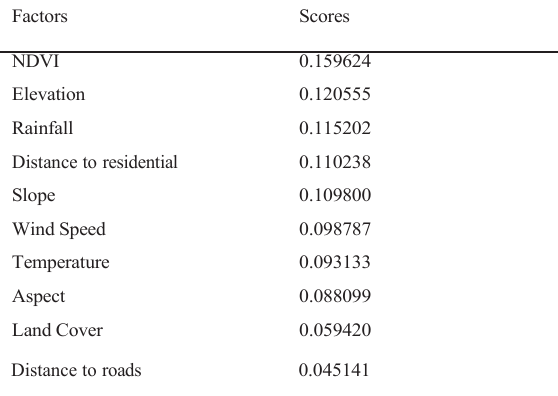
Table 5. Scores of importance conditioning